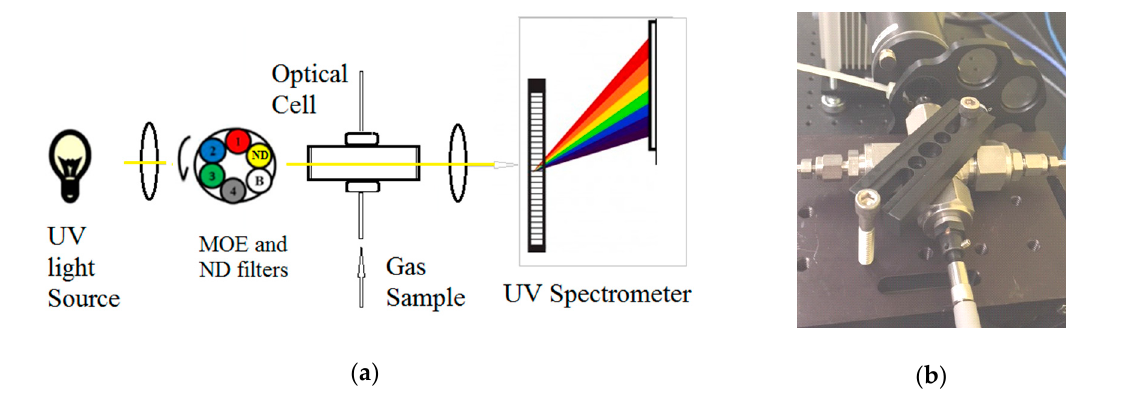
Figure 8. ( a ) Schematic setup of MOC prototype system for H 2 S test, channel number 1 to 4 are replicates of MOE, channel B is blocker channel to block the light, channel ND includes a 25% neutral density filter; ( b ) the picture of experiment setup.